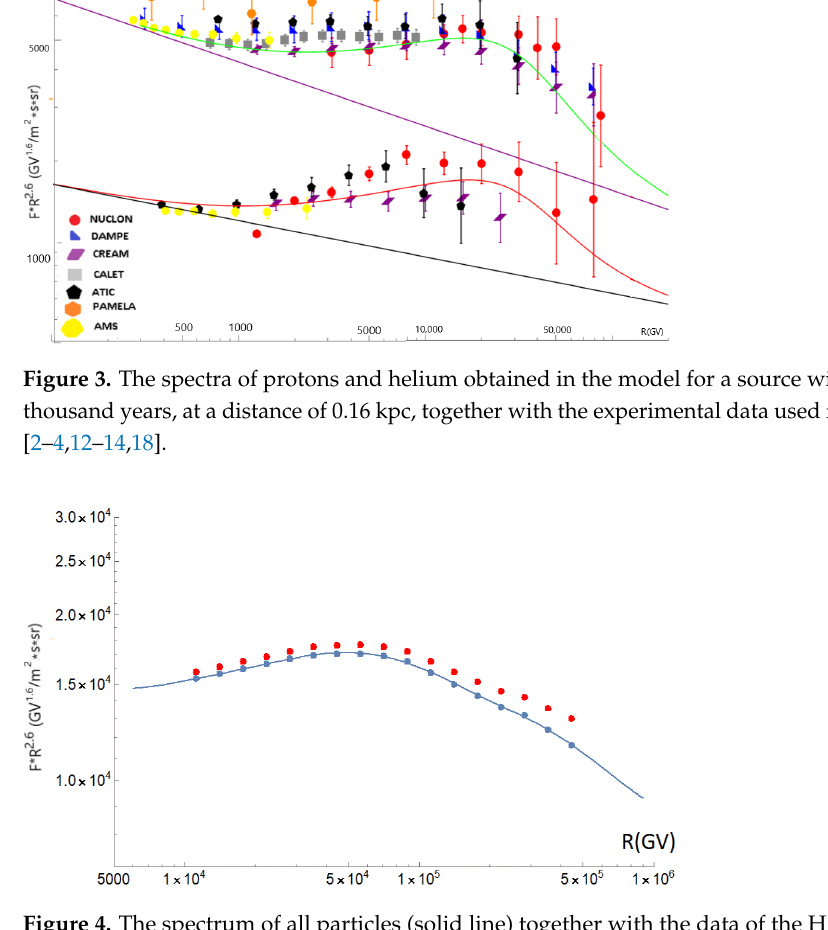
Figure 4. The spectrum of all particles (solid line) together with the data of the HAWC experiment: the starting points are marked in red; the points taking into account the penalty parameters are